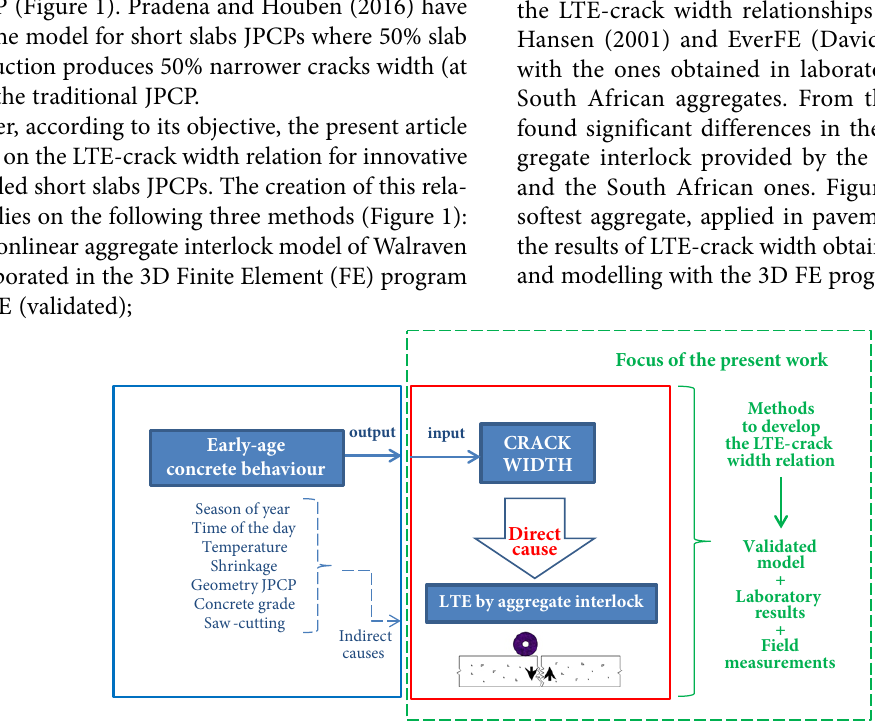
Figure 1. Research approach, focus on the present work and methods to develop the LTE-crack width relation